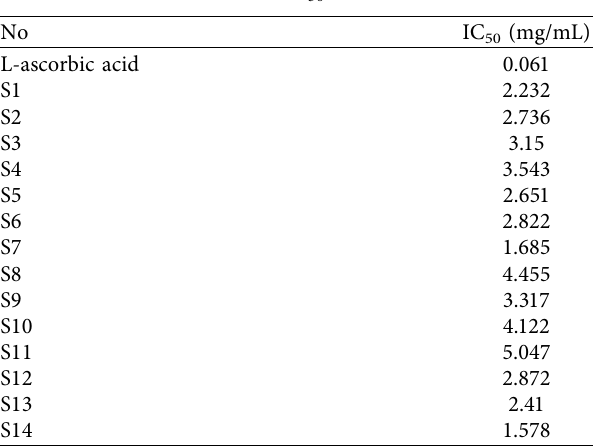
Figure 4: UV absorption spectra of the reference favonoids: (a): hesperidin, (b): tangeretin, (c): Nobiletin, and (d): 5-demethylnobiletin. Table 8: IC 50 values.